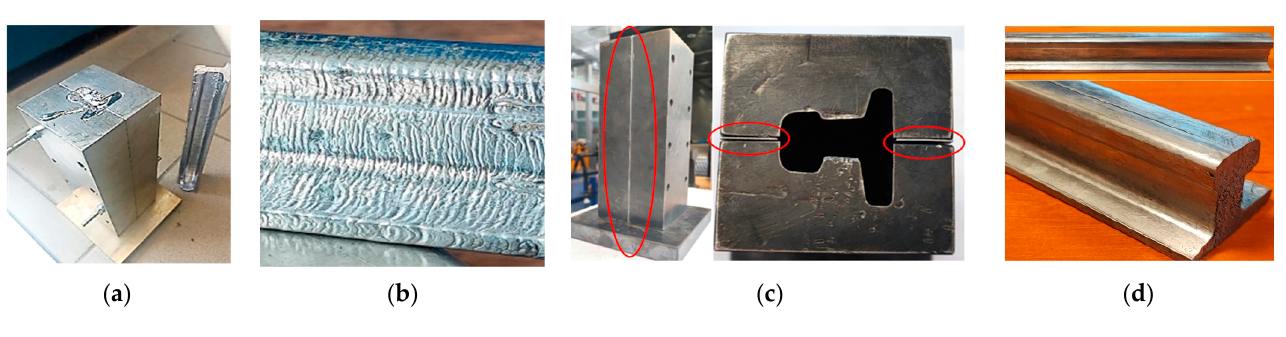
Figure 10. Images of: ( a ) the physical modeling station, ( b ) the lower tools for three operations of reforging a lead rail, ( c ) the formed rails placed in the lower dies. To verify the physical modeling, we compared a 3D scan of the reforged needle rail made of Pb to the nominal CAD model, which is shown in Figure 11. Figure 11. Results: ( a ) a photograph of the lead rail after the last forming operation, ( b ) a comparison of the shape and dimensions from FEM with the experiment, with a map of deviations (green color is best fit).